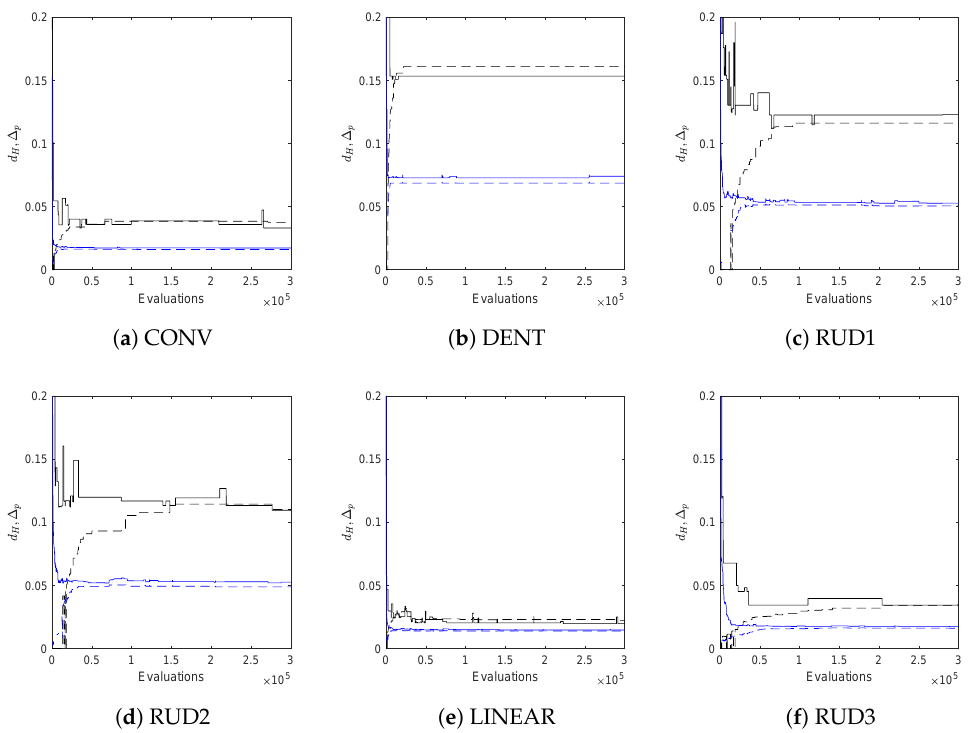
Figure 5. Hausdorff and averaged Hausdorff approximations ( d h and ∆ 2 , respectively) obtained by ArchiveUpdateHD for one single run for six bi-objective problems (see Figure 4) together with their approximations h and d 2 . d H is plotted black solid, h is black dashed, ∆ 2 is blue solid, and d 2 is blue dashed.